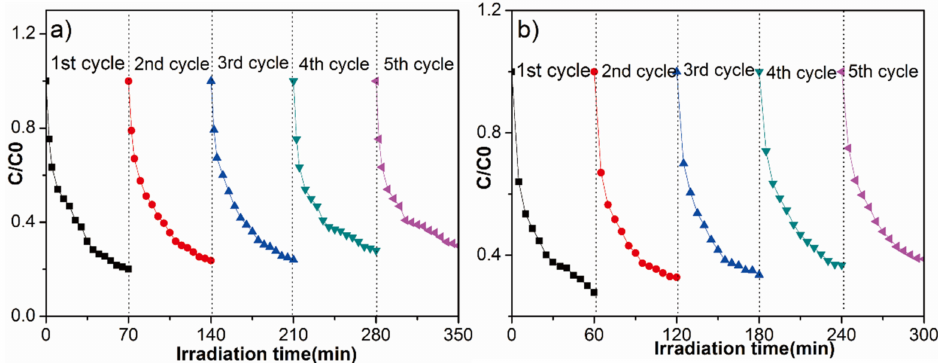
Figure 11. The stability study for the photocatalytic MO ( a ) and TC ( b ) degradation by 2Fe( Ш